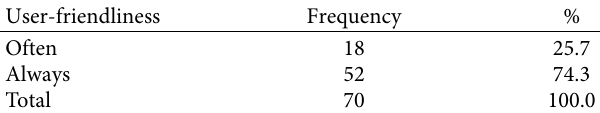
Table 15: Descriptive statistics.